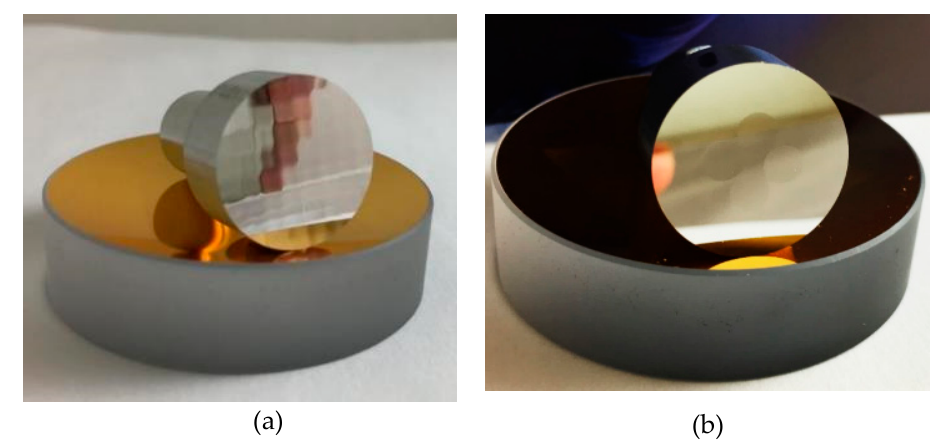
Figure 18. ( a ) Machined sinusoidal grid surface sample; ( b ) Machined micro-lens array (MLA) surface sample.